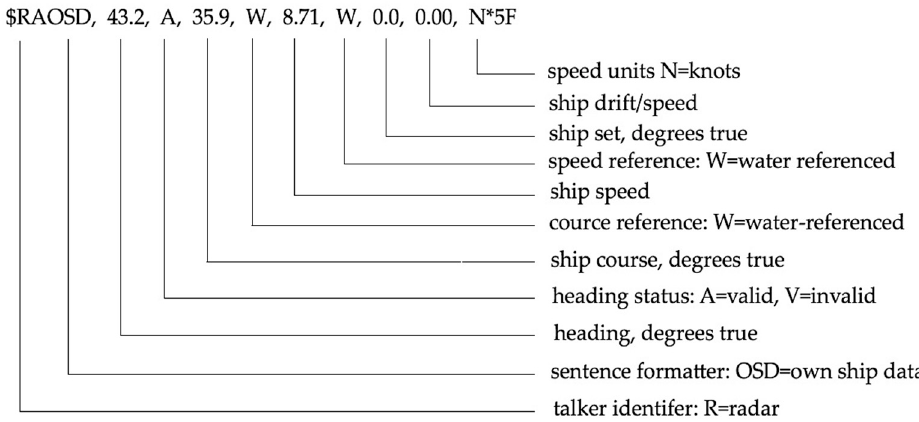
Figure 4. The format of the data frame with the sample parameters of one’s own ship.